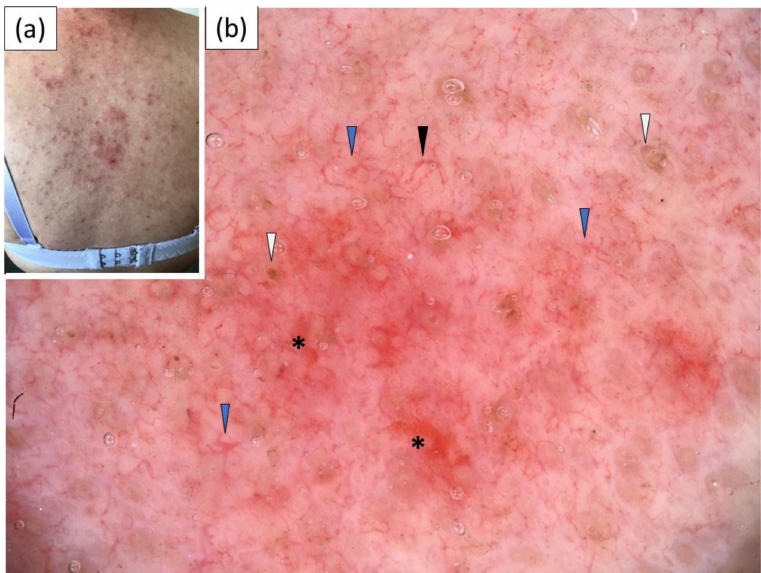
Figure 1. ( a ) Clinical presentation of acute cutaneous lupus erythematosus (ACLE) on the back; ( b ) videodermoscopic findings: linear (black arrowhead) and linear branched vessels (blue arrow- head), follicular plugs (white arrowhead) and red structureless (hemorrhagic) areas (black asterisk).